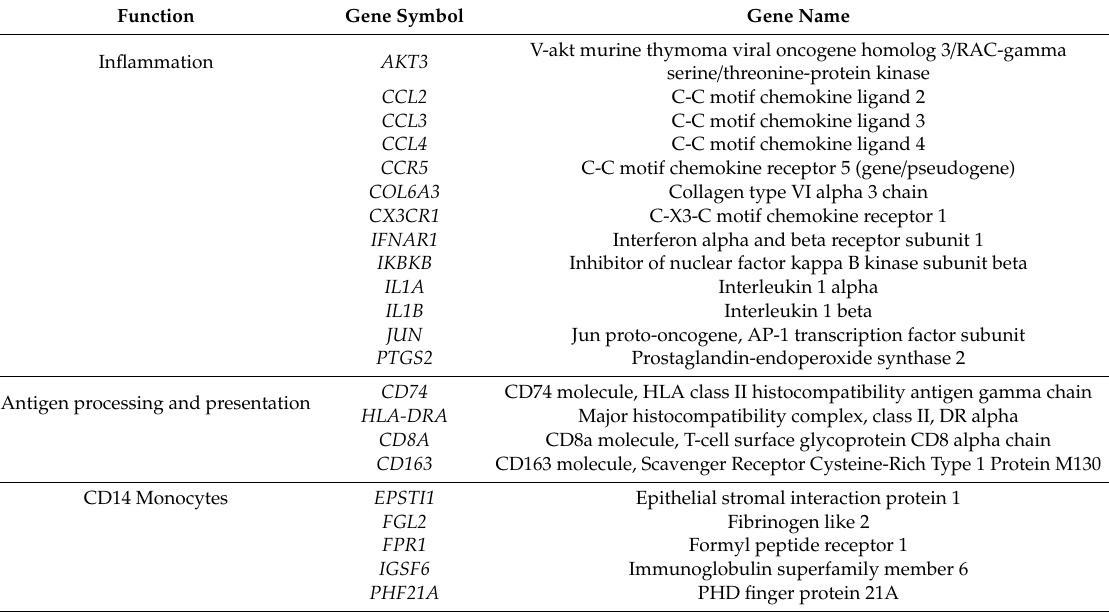
Table 11. Nanostring validation